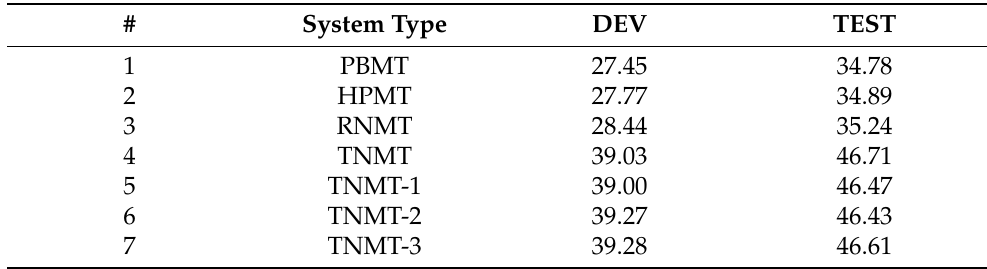
Table 3. The BLEU score of single systems. DEV and TEST represent the BLEU score on development set and test set,